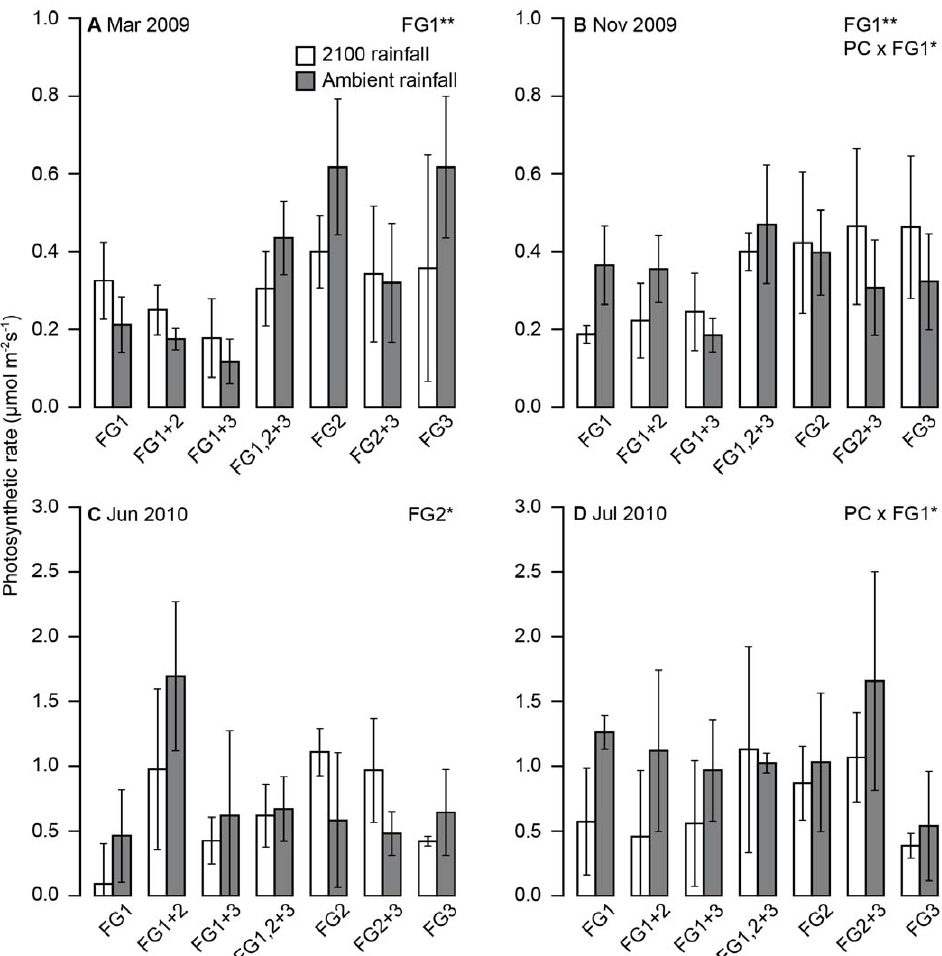
Figure 3. Effect of precipitation change and functional identity on photosynthetic rate at different time points. The response of photosynthetic rate to precipitation change (PC) and functional group (FG) identityat four time points through the experiment. a) March 2009 (presence/absence of FG1, F 1,42 =9.152, p=0.004), b) November 2009 (interaction between PC and FG1, F 1,42 =4.831, p=0.033), c) June 2010 (presence/absence of FG2, F 1,42 =4.610, p=0.037), d) July 2010 (interaction between PC and FG1, F 1,42 =5.552, p=0.004). Error bars represent 6 1 SEM.